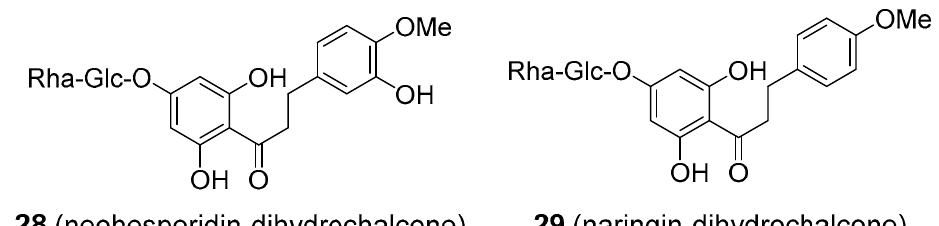
Figure 6. Glycosylated dihydrochalcones used as non-sugar sweeteners.